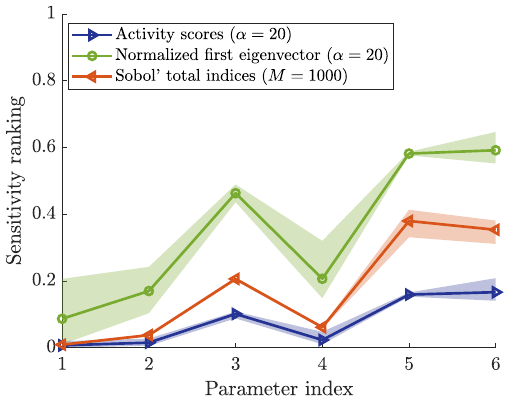
Figure 13. Normalized activity scores, and Sobol’ indices for the bottleneck scenario with the new range for the personal space strength ( [ 40,60 ] ). The parameter index is mapped as follows: 1—control parameter, 2—free-flow speed mean, 3—free-flow speed standard deviation, 4—number of agents, 5—bottleneck width, 6—personal space